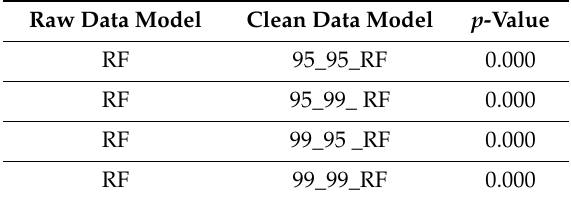
Table 19. p -value for t -test comparison for the RF (raw data model) against RF (cleaned data models) when tested against raw